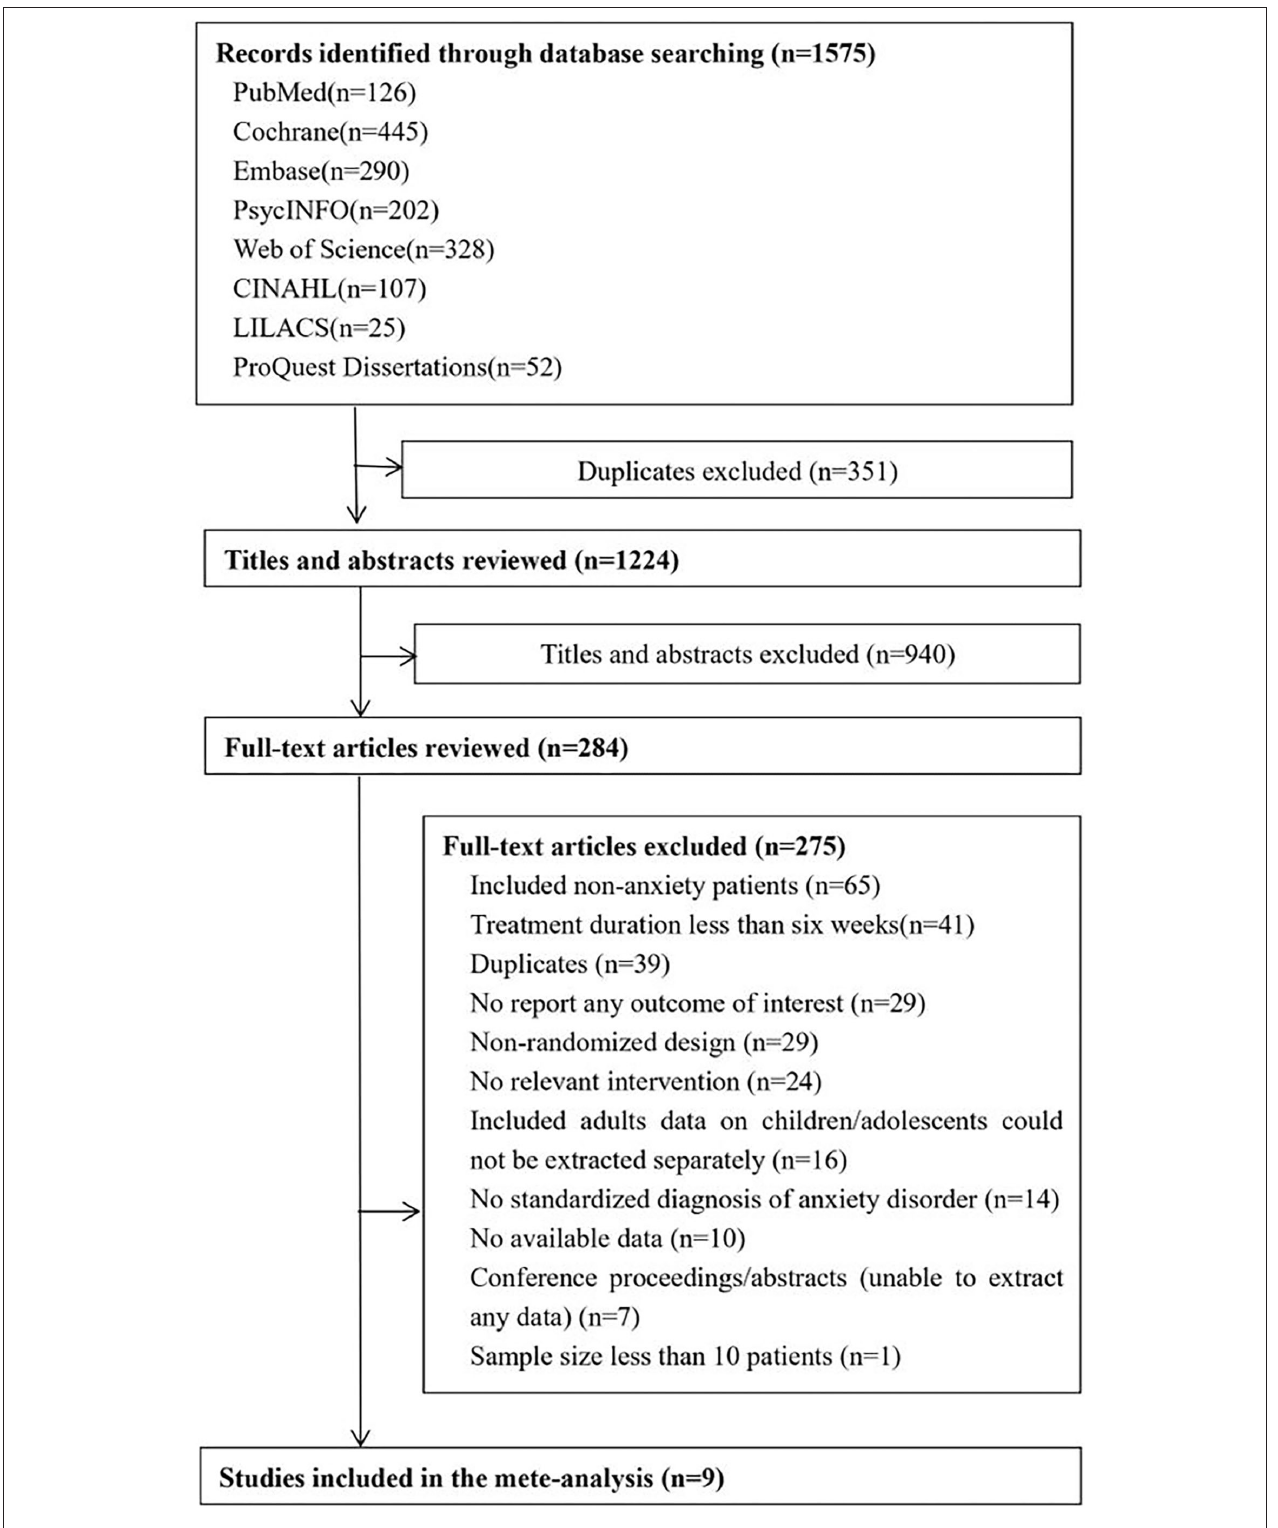
FIGURE 1 | Flow chart of the study